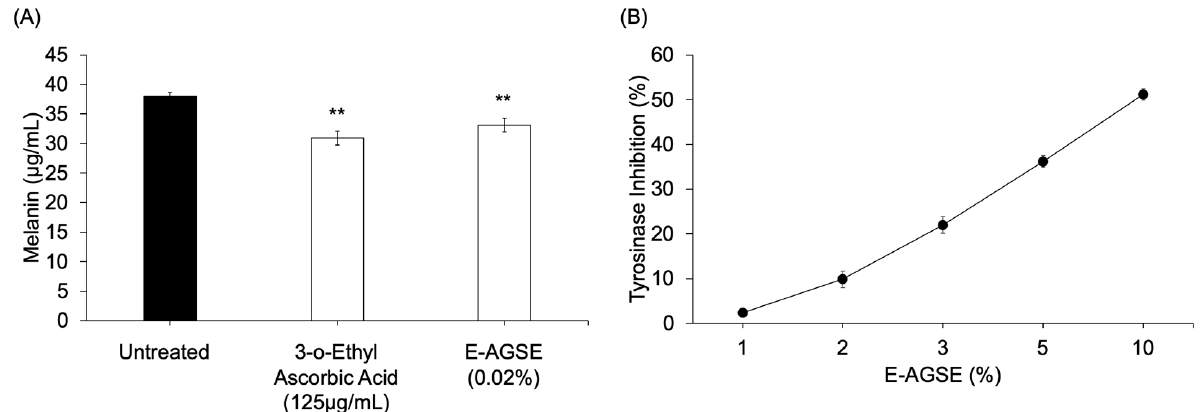
Figure 4. E-AGSE reduces melanin production and inhibits tyrosinase enzyme activity. ( A ) Normal human melanocytes (NHMCs) were treated with the indicated concentrations for 72 h and harvested for melanin content evaluation. The level of melanin was quantitated by colorimetric assay. The data represent the average ± SD of cumulative from three independent experiments. ** p ≤ 0.01 indicates a statistically significant difference compared to untreated cells. ( B ) Mushroom tyrosinase enzymatic activity was evaluated using L-DOPA substrate and activity was monitored by dopachrome formation via optical density (475 nm). The data represent the average ± SD of cumulative from three independent experiments.